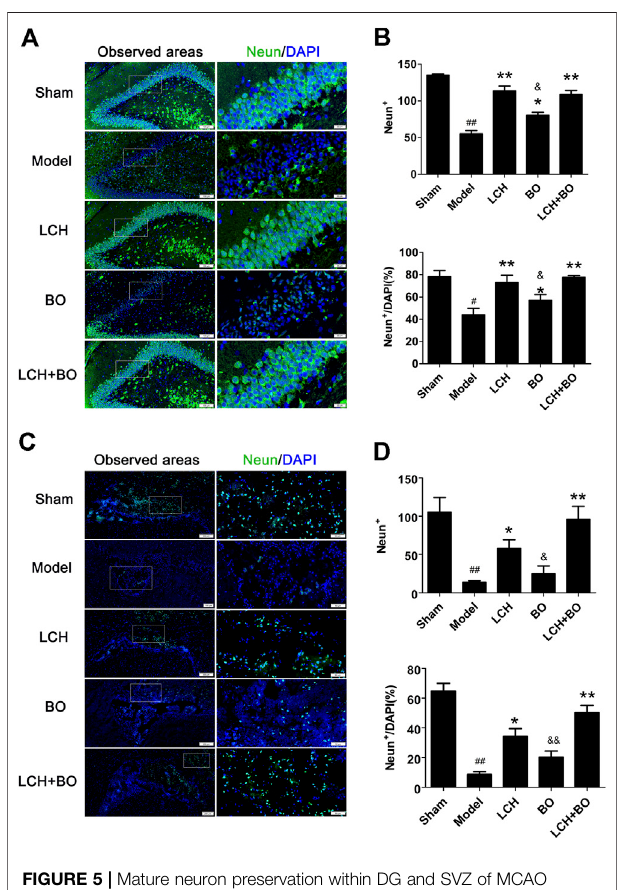
FIGURE 5 | Mature neuron preservation within DG and SVZ of MCAO rats. (A) Representative immunostaining images of NeuN in the DG area. (B) The results of NeuN + cells and NeuN + /DAPI in the DG area ( n (cid:1) 3). (C) RepresentativeimmunostainingimagesofNeuNintheSVZarea. (D) The resultsofNeuN + cellsandNeuN + /DAPIintheSVZarea( n (cid:1) 3). # p < 0.05, ## p < 0.01 compared to the sham group; * p < 0.05, ** p < 0.01 compared to the model group; & p < 0.05, && p < 0.01 compared to the LCH + BO group.